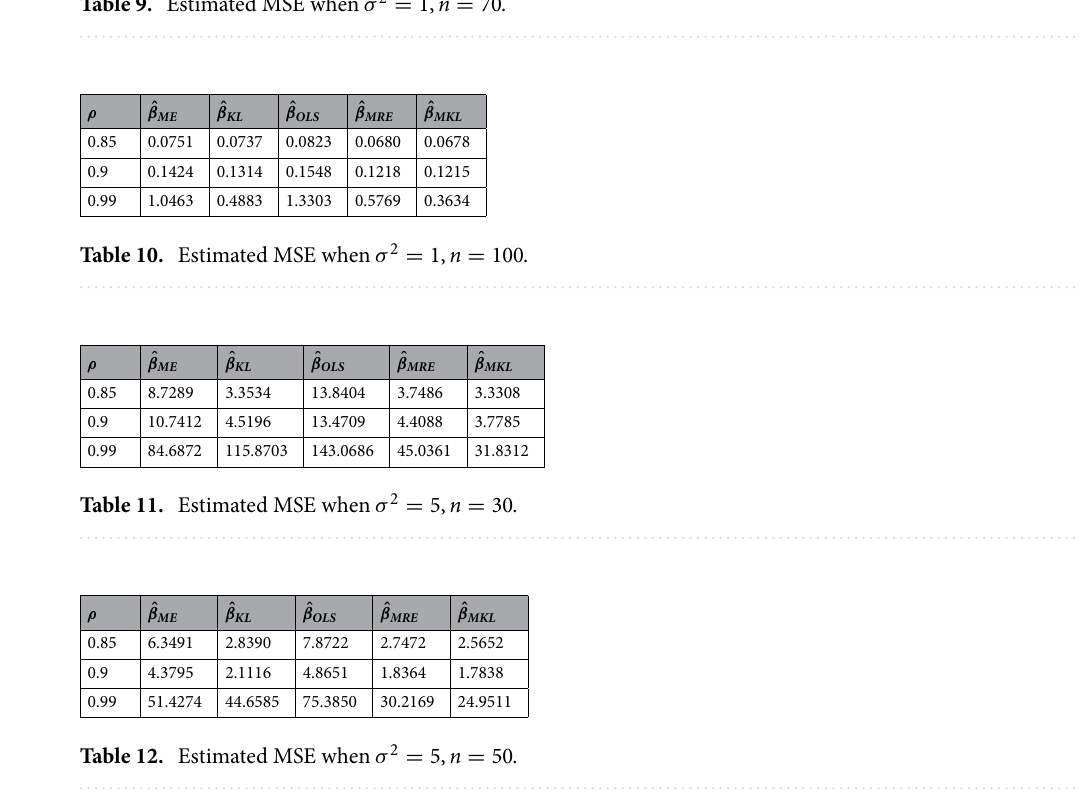
Table 12. Estimated MSE when σ